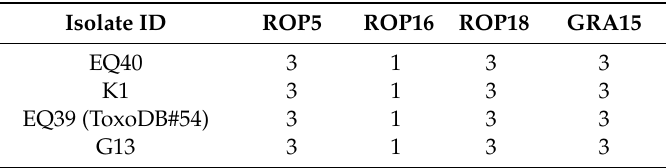
Table 3. Virulence marker allele